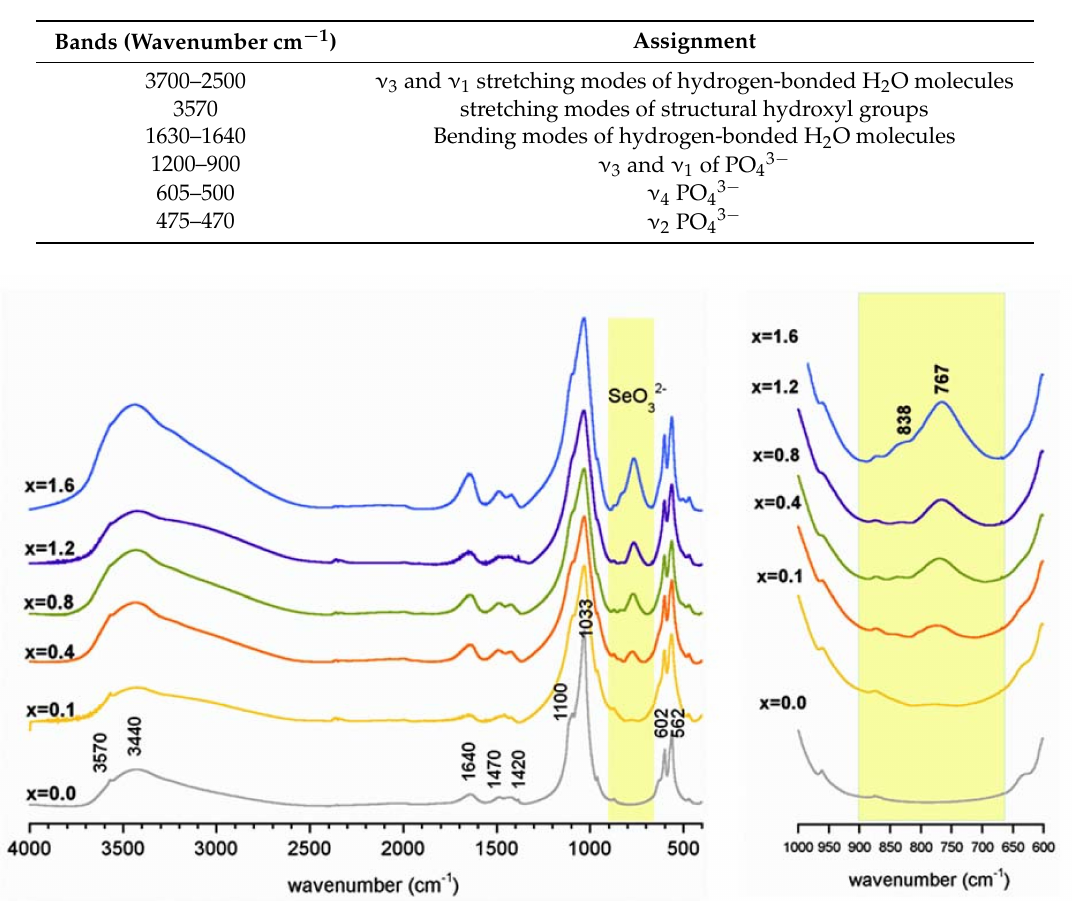
Table 1. Main FT-IR bands of HA [36,38,43,45,46].